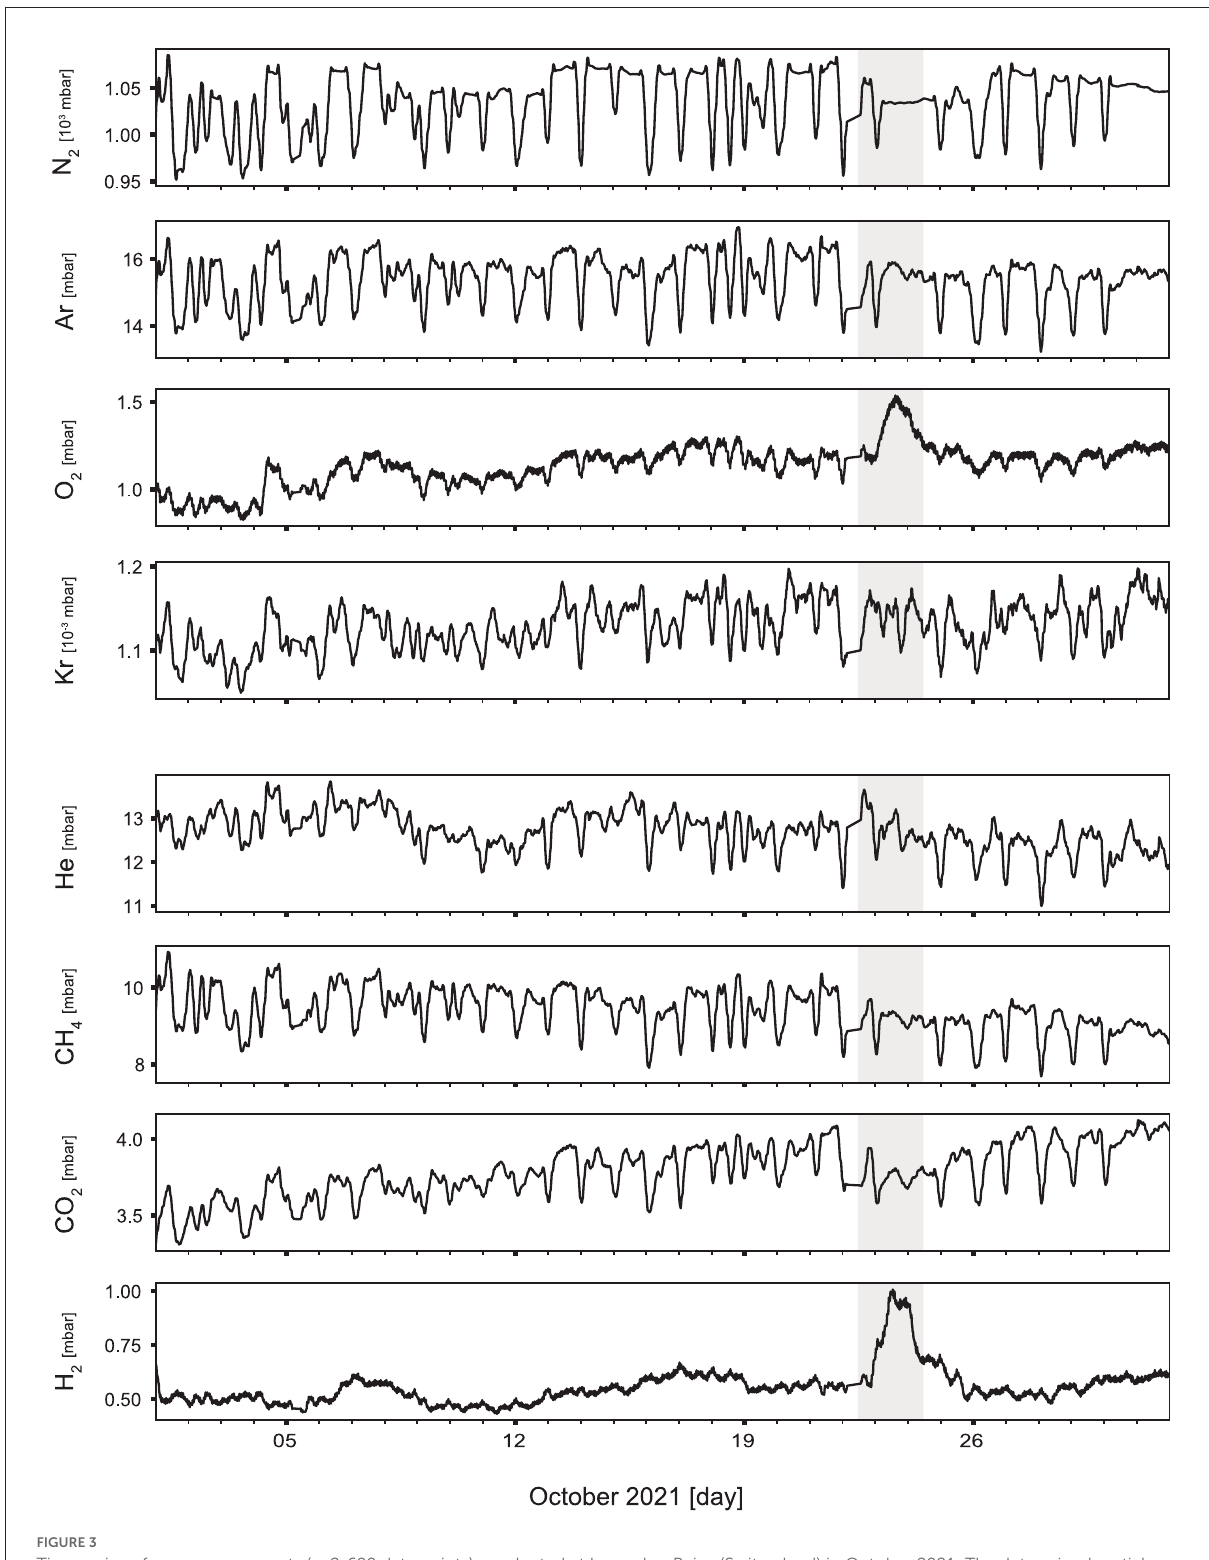
FIGURE3 Time series of gas measurements ( > 2,600 data points) conducted at Lavey-les-Bains (Switzerland) in October 2021. The determined partial pressures [mbar] of N 2 , Ar, O 2 , Kr (atmospheric gases), He, CH 4 , CO 2 , and H 2 (geogenic gases) are plotted using Savitzky-Golay filtering (frame length 27 and order 3) to smooth the curves. On October 22, the P201 pump was offline for a duration of 8h due to an operation failure. The different peaks in the shaded area, such as those in the concentrations of H 2 and O 2 , are possible effects of the pumping